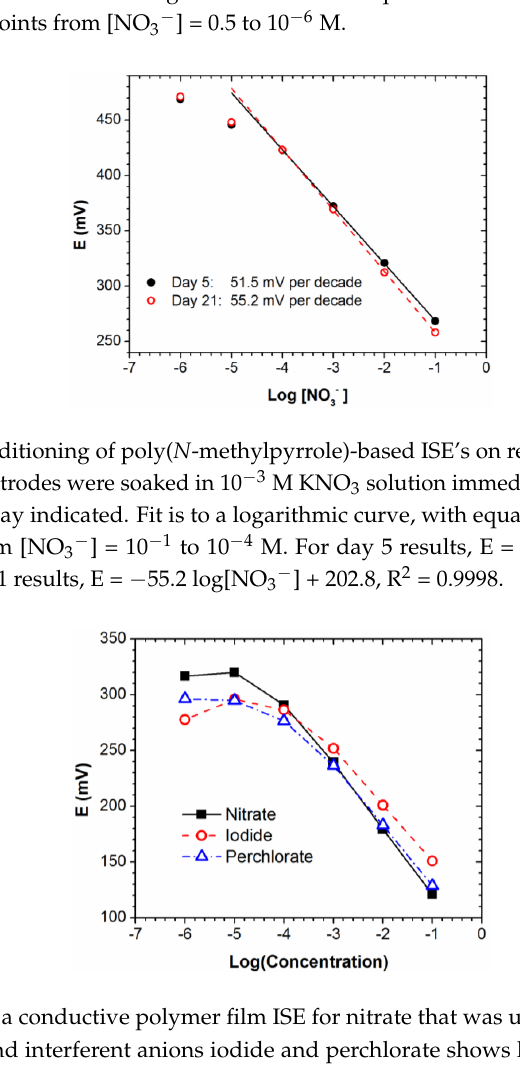
Figure 3. Response of a conductive polymer film ISE for nitrate that was undoped after film growth. Response to nitrate and interferent anions iodide and perchlorate shows little selectivity for nitrate against the interferents.